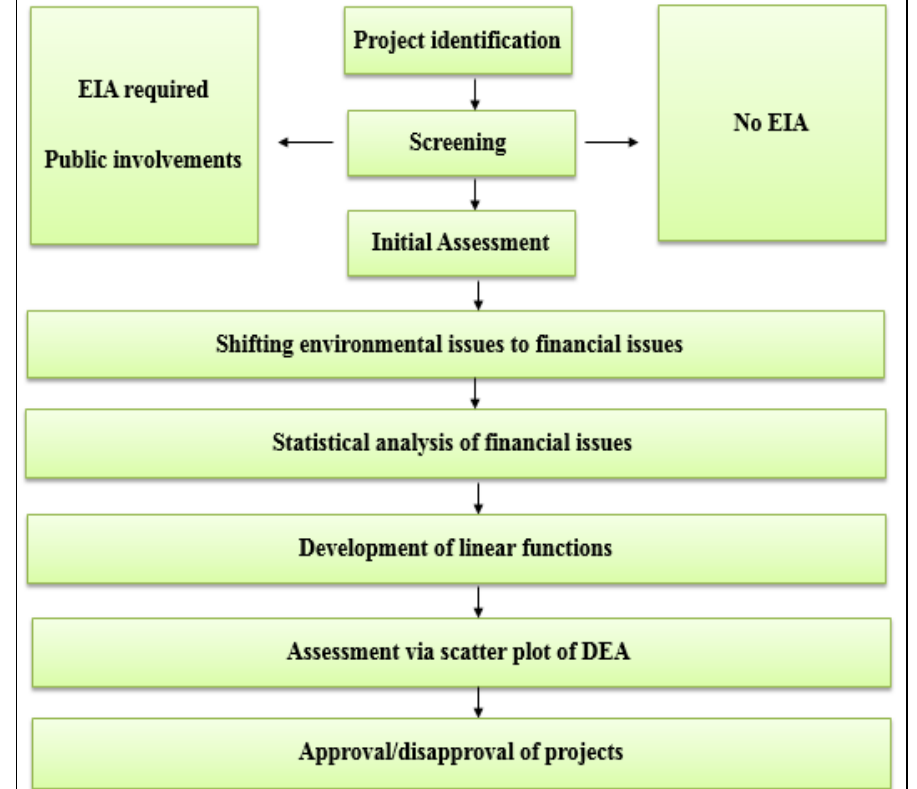
Figure 1. The evaluation steps of EIA and followed work for current